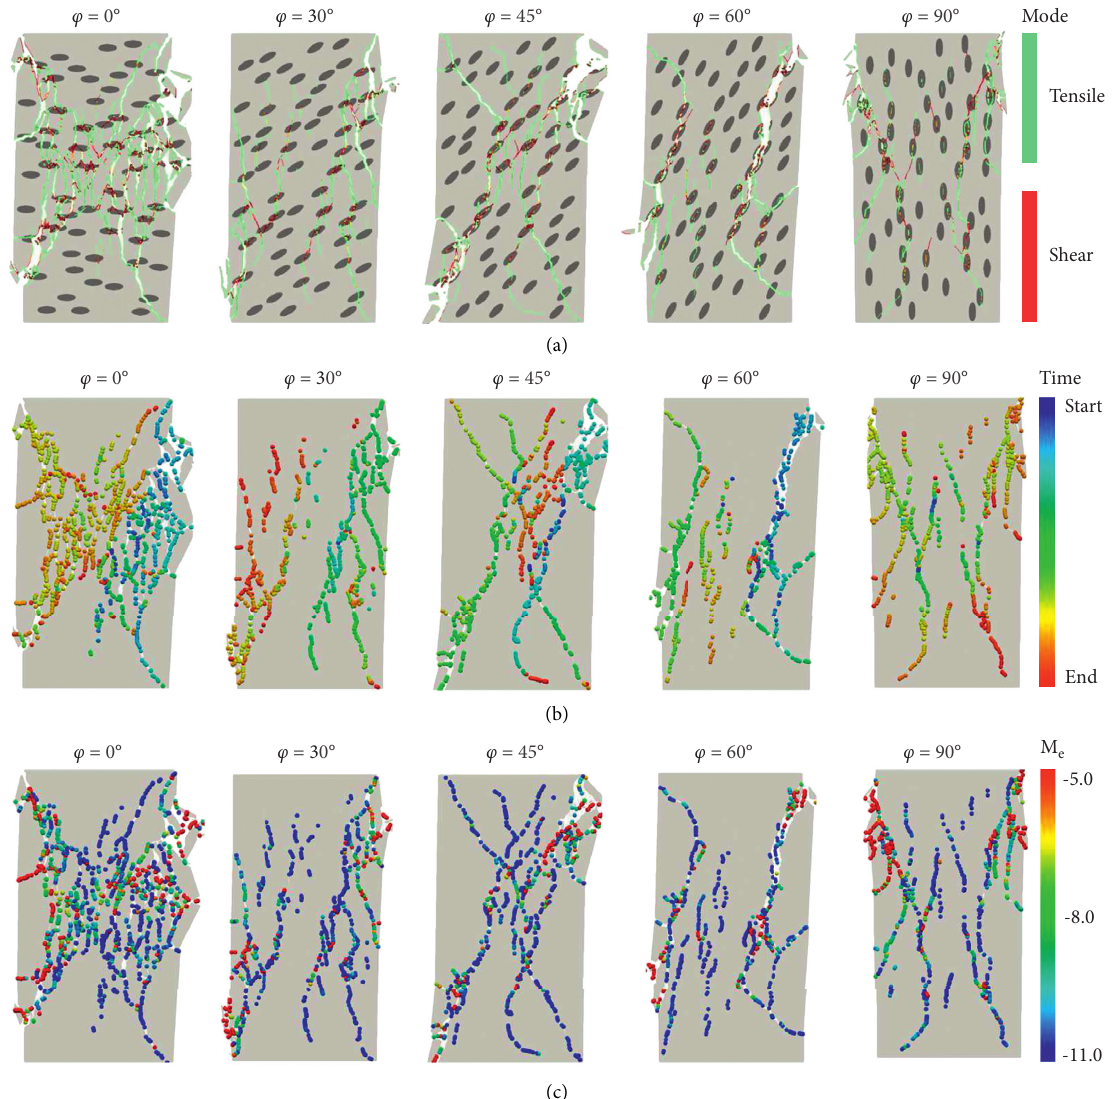
Figure 11: (a) Failure phenomenon under different orientations of amygdale conditions (green � tensile crack and red � shear crack, respectively); (b) the AE evolution; (c) the AE events energy, Me, measured based on the kinetic energy of the AE